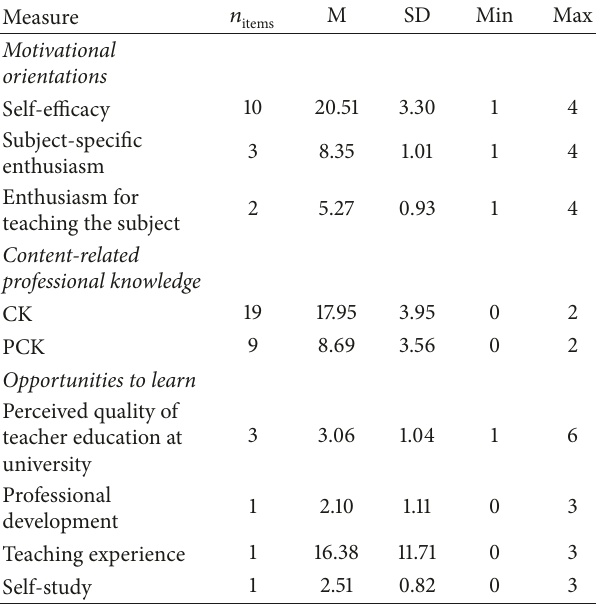
Table 1: Descriptive